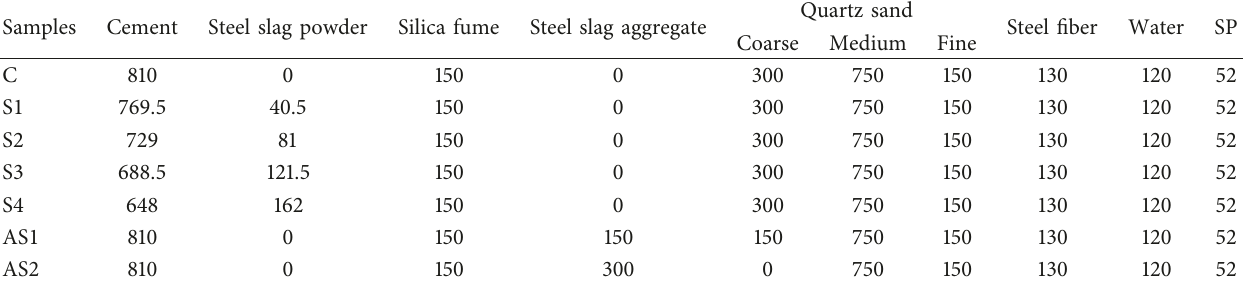
Table 3: Mix proportions of concretes (kg/m 3 ).